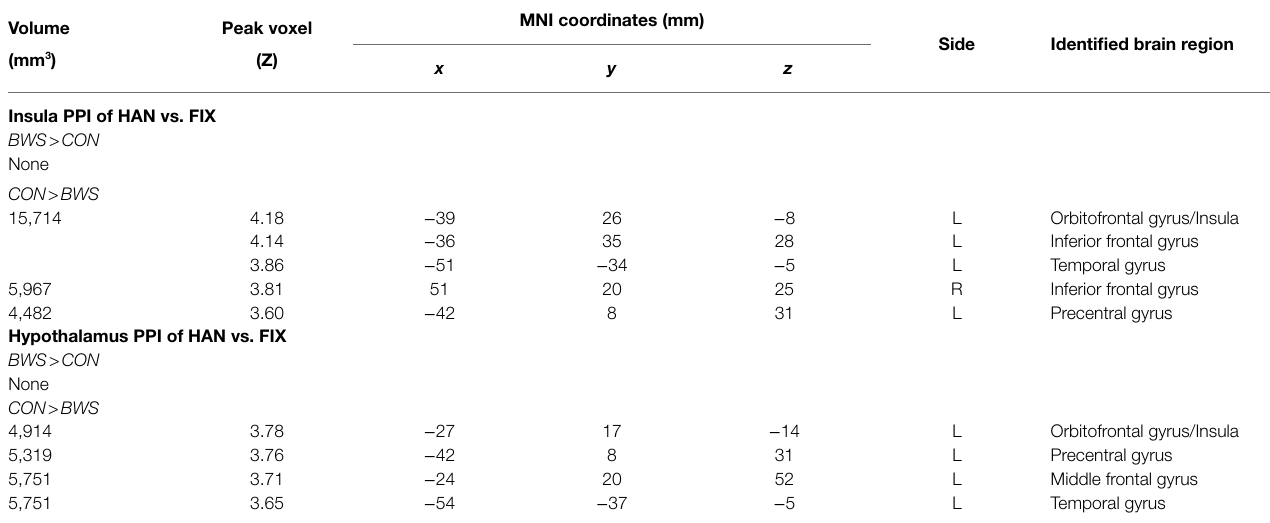
TABLE 4 | Regions showing differences in PPI between BWS and CON with age as a